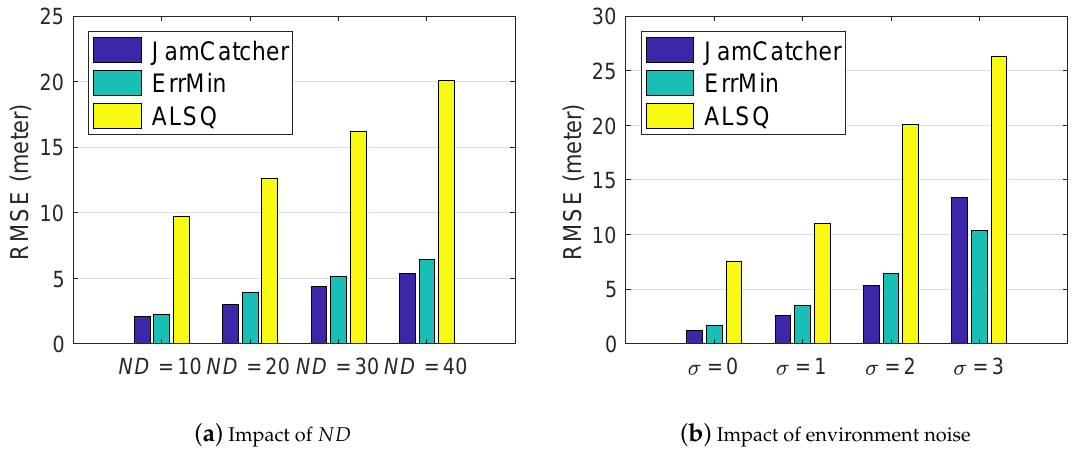
Figure 10. Impact of ND and σ on the performance of JamCatcher , ErrMin and ALSQ